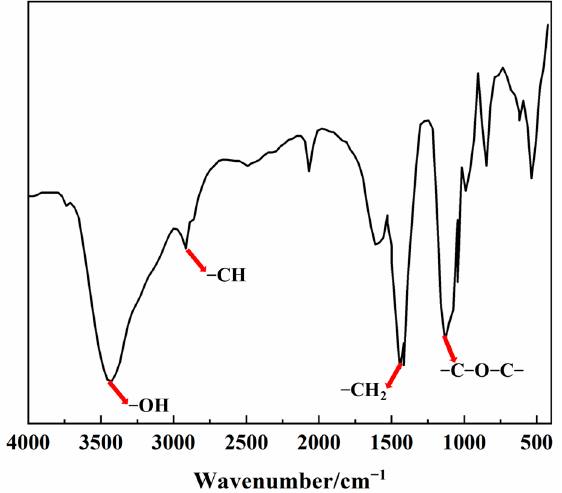
Figure 1. FTIR spectrum of the synthesized SRP − 1.